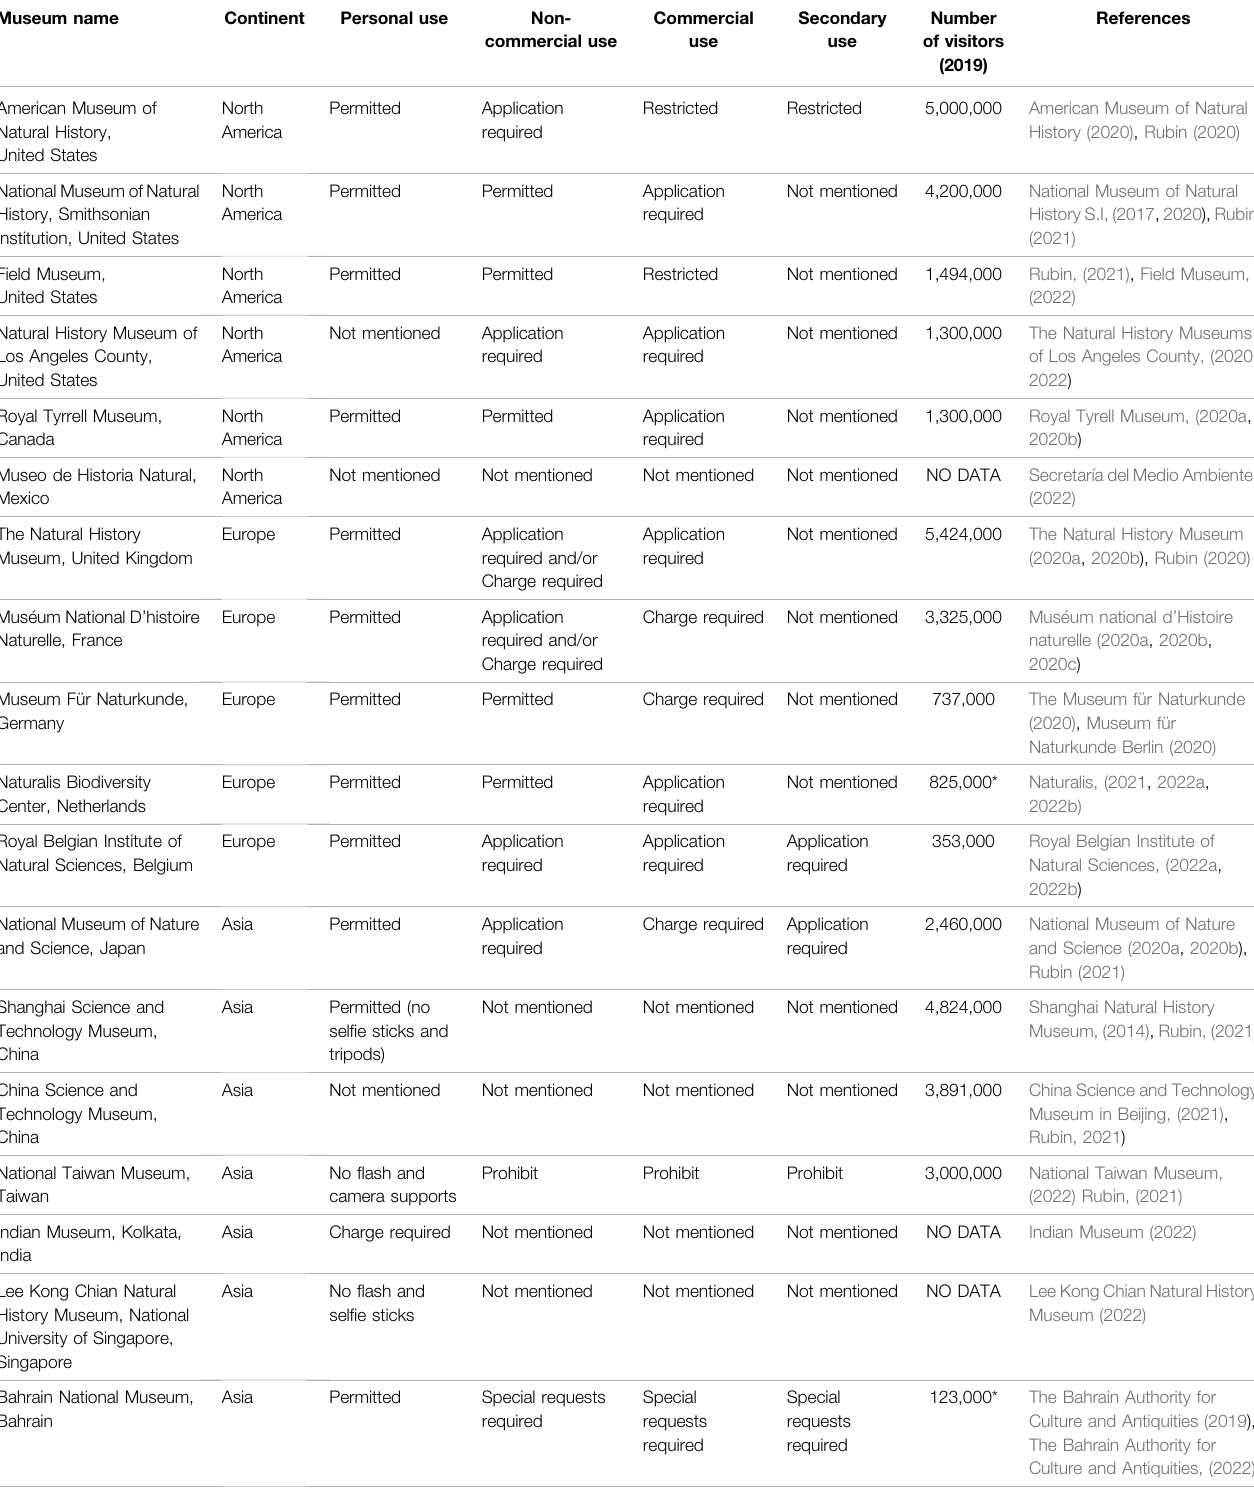
TABLE 1 | Policies about photography in major natural history museums